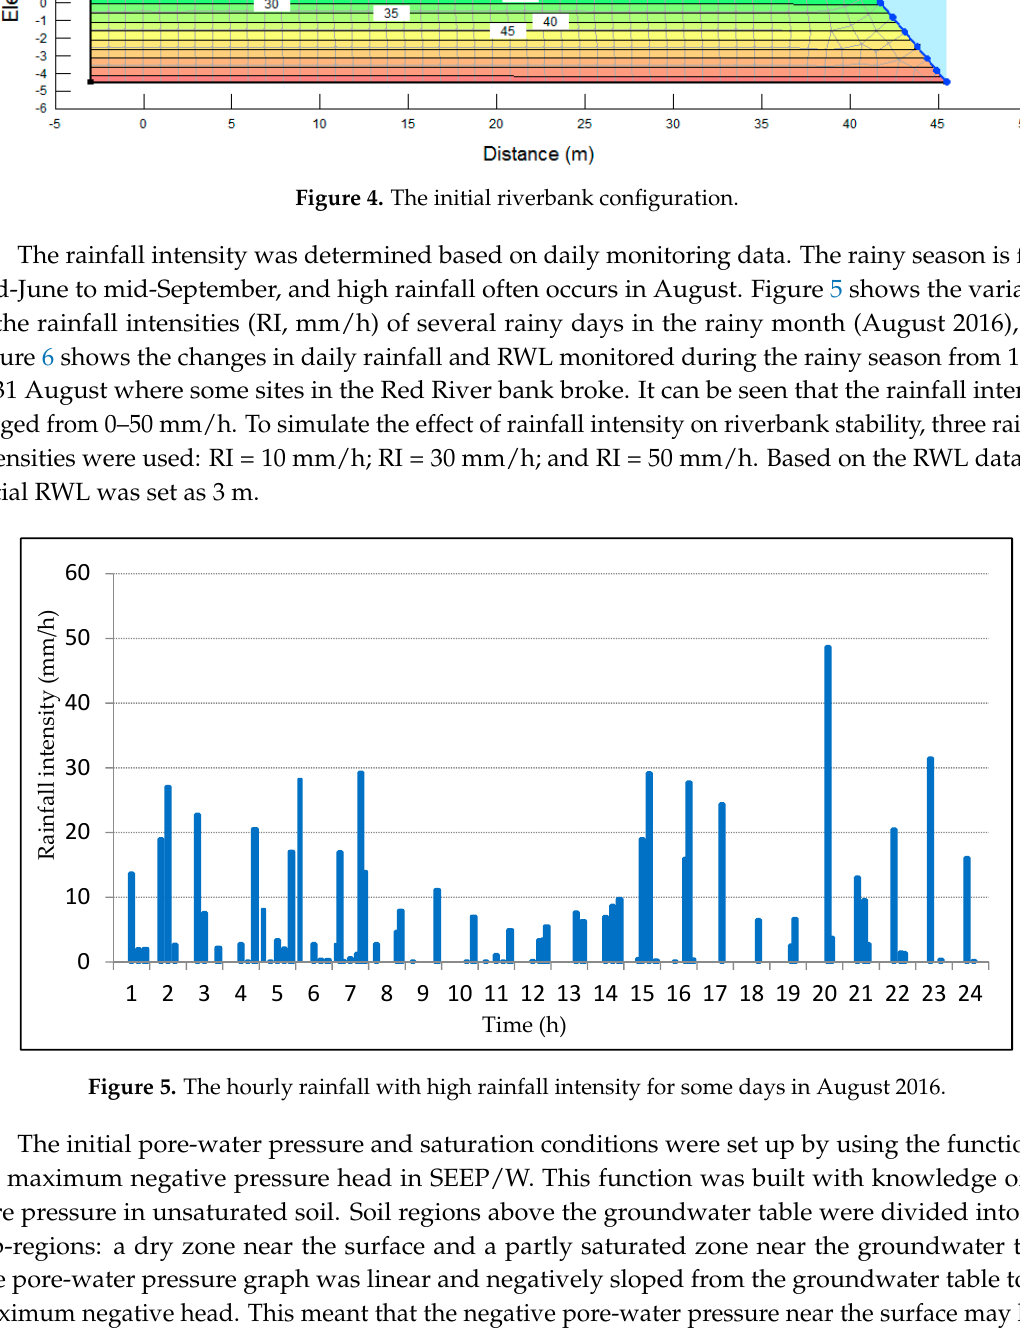
Figure 6. Daily river water level (RWL) and daily rainfall from 1 July to 31 August 2016.